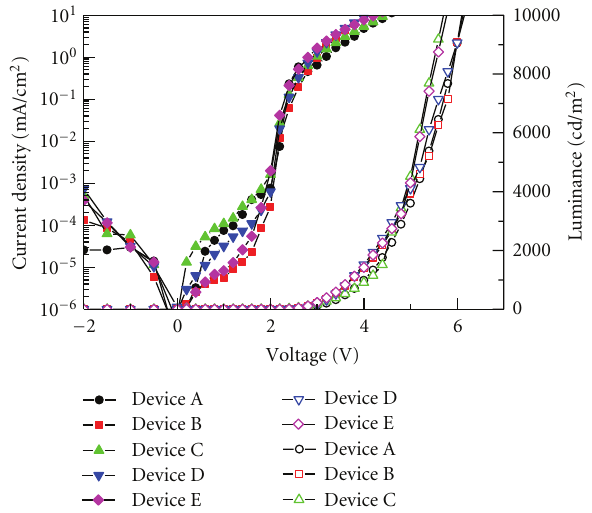
Figure 16: J - V - L characteristics of fabricated red